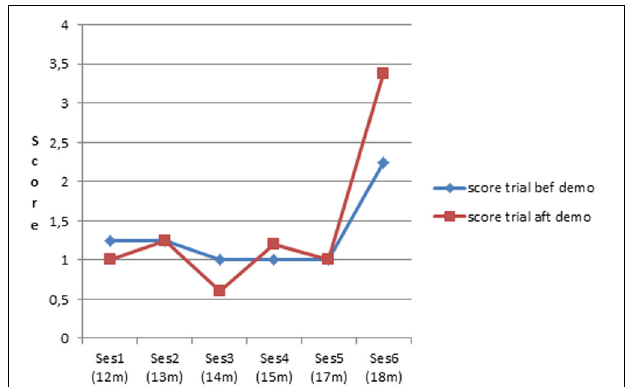
FIGURE 7 | Individual profiles in C4–C5.